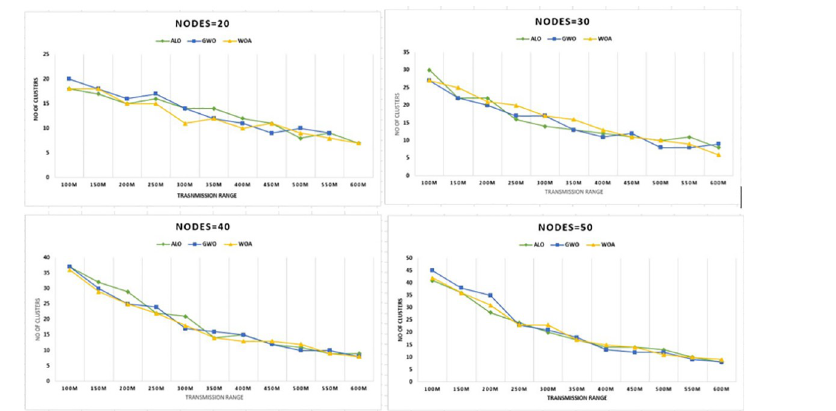
Fig 7. Transmission range versus CHs for nodes 20–50 & grid size 2km x 2km.